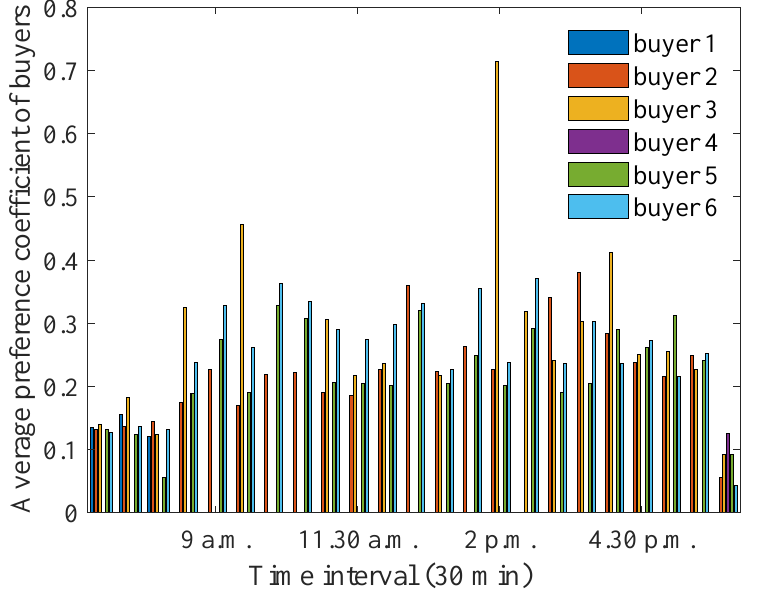
Figure 18. Optimum preference coefficients for buyers when distance between house 1 and the aggregator is